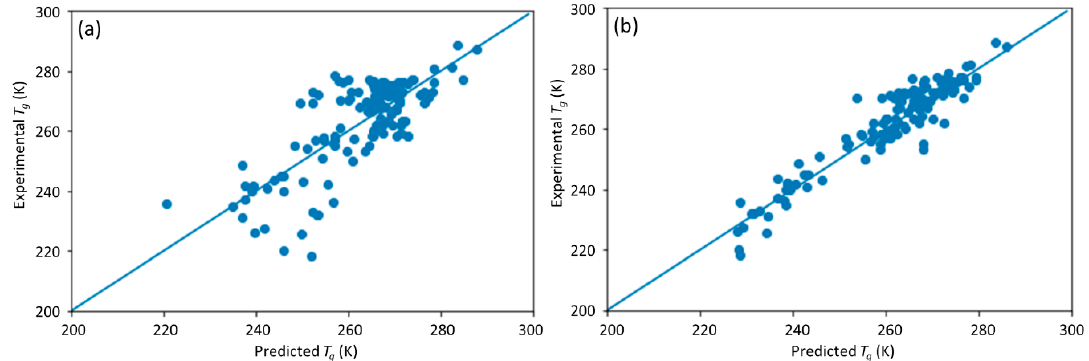
Figure 5. The scatter plot of the predicted vs. experimental T g after retraining the DNN model with the combined initial and symmetry data set; ( a ) results with initial data set; ( b ) results with symmetry data set.